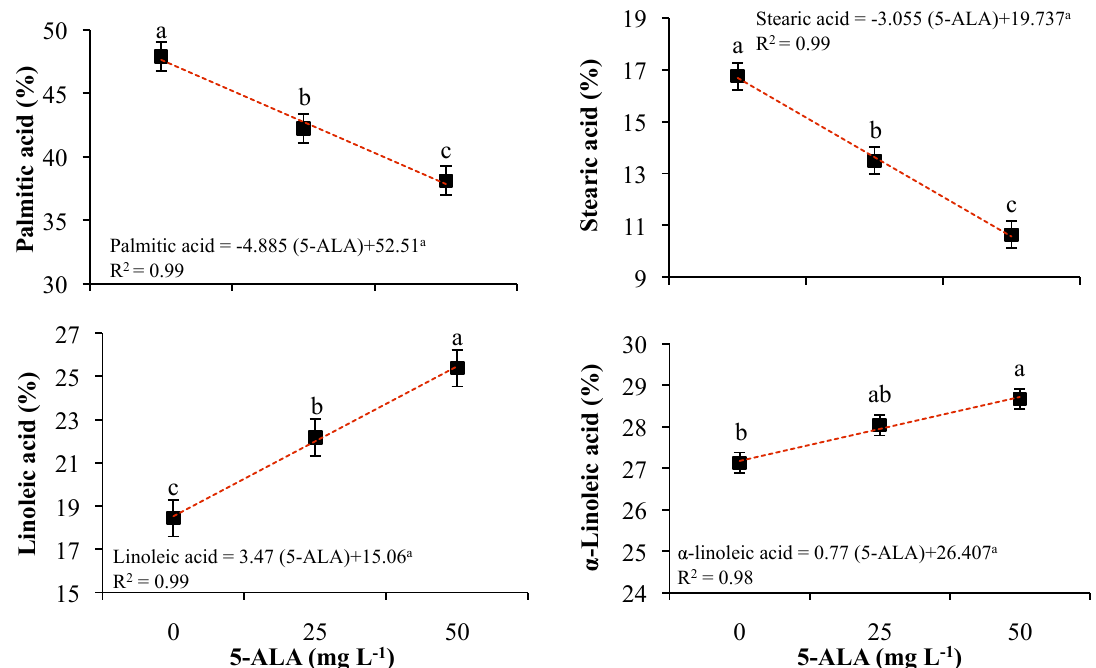
Fig. 4: Percentage of palmitic (16:0), stearic (18:0), linoleic (18:2ω6), and α-linolenic (18:3ω3) acids of the total fatty acids in leaves of Portulaca oleracea L. in response to foliar application of 5-ALA. Means marked by the same letter are not significantly different according to DMRT at P ≤0.05. Error bars represent standard deviation. a The fatty acids are expressed in percentages of the total fatty acids; (5-ALA) = applied 5-ALA (mg L -1 ); R 2 = multiple determination coeffcient.